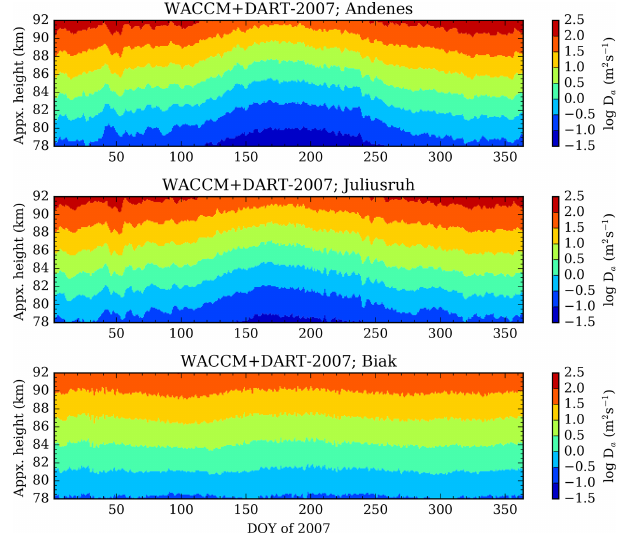
Figure 1. Diffusion coefficient ( D a ) measured by SMRs located at high (Andenes, 69 ◦ N, a ), middle (Juliusruh, 55 ◦ N, b ), and low latitudes (Biak, 1 ◦ S, c ) are shown. Notable features like increased D a at lower altitudes are protruding out in the middle- and high- latitude stations during summer.